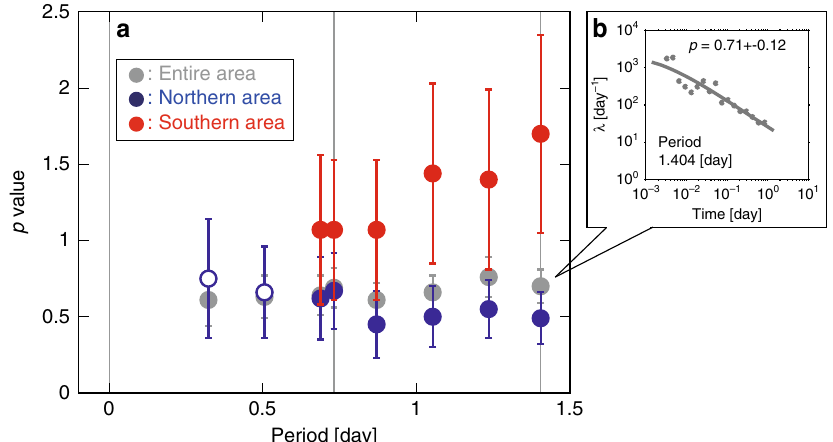
Fig. 4 Fitting of the OU law. a Plot of p -value of the OU law as a function of the length of the analyzed period since the M 6.4 quake, based on seismicity ( M ≥ 3) during the period between M 6.4 and M 7.1 quakes along the fault such that the M 7.1 ruptured in the entire area (grey), in the northern area (North of 35.72°N) (blue), and in the southern area (South of 35.72°N) (red). The maximum-likelihood fi t was used to determine a p -value. Uncertainties in p were computed by bootstrapping. Open circles for the northern area show p -values obtained based on N ≤ 20 earthquakes. For the periods ≤ 0.5 days, no p -value was obtained for the southern area, because the solution did not converge due to not enough data analyzed. Vertical lines indicating the periods of 1.404, 0.732, and 0 days correspond to the periods ending at the time of the M 7.1, M 5.4, and M 6.4, quakes, respectively. b Number λ (day − 1 ) of seismicity ( M ≥ 3) as a function of time from the M 6.4 quake for the analyzed period of 1.404 days in the entire area (grey).